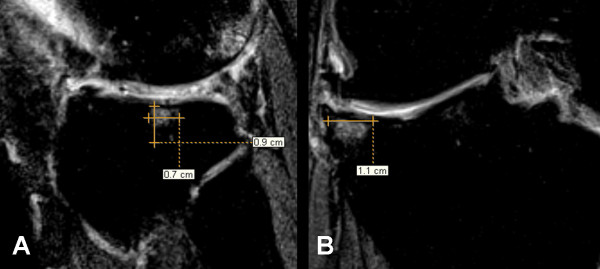
Bone marrow lesion measurements within the lateral tibia. a. In the sagittal image the superior-inferior dimension (0.9 mm) and anterior-posterior dimension (0.7 mm) are measured. b. In the coronal image the medial-lateral dimension is measured (1.1 mm). The image contrast is optimized for measuring bone marrow lesions based on the measurement protocol (not for viewing other anatomical structures).